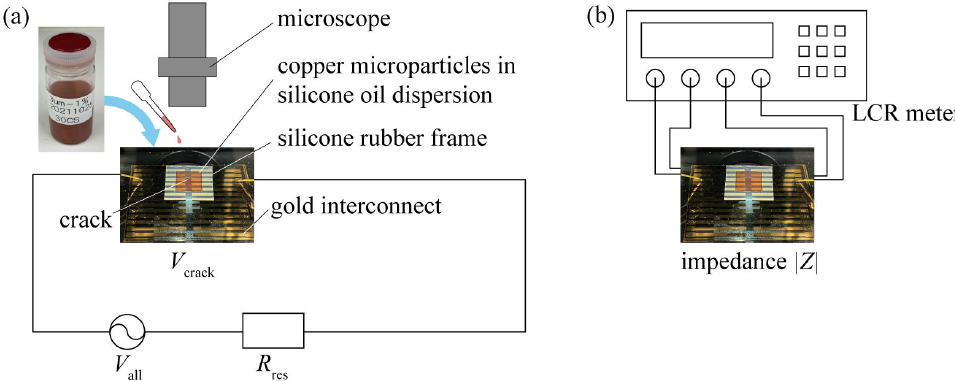
Figure 2. Experimental setup for evaluation of bridging and conduction morphology of copper microparticles. ( a ) Observations regarding physical bridging. ( b ) Impedance measurement for electrical conduction.